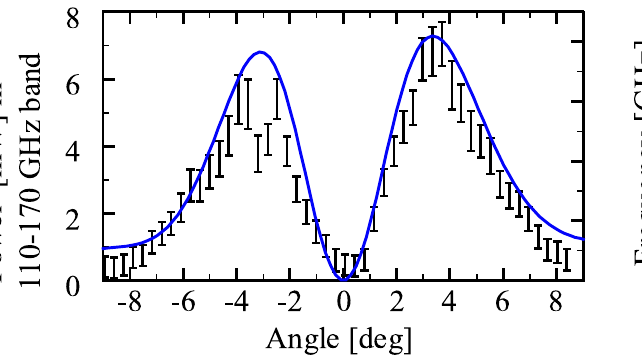
FIG. 6. (Color) CTR frequencies measured with the double heterodyne receiver, open circles. Radiation is only observed at integer harmonics of the rf frequency. The straight line is a fit to the data and has a slope consistent with the accelerator frequency of 17.14 GHz.